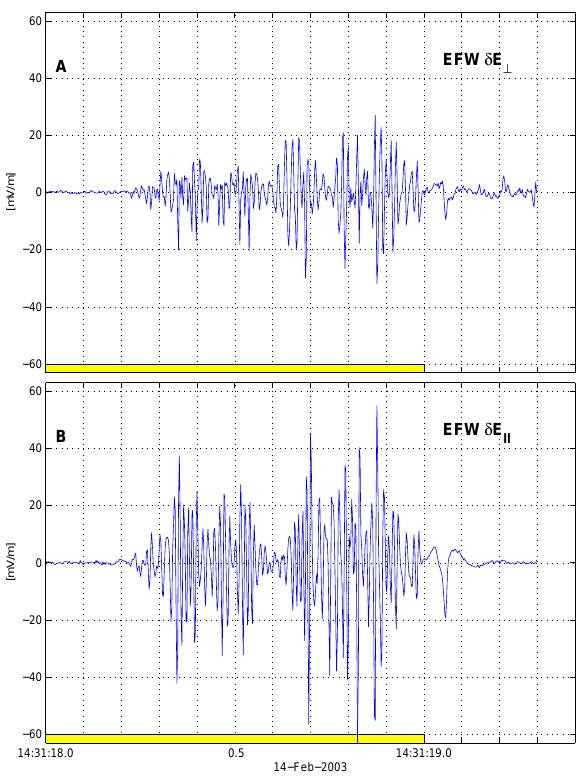
Fig. 10. For 1.3s of data, including the one-second period high- lighted in yellow (also in Fig. 5) showing perpendicular (panel A ) and parallel (B) components of the electric field. By visual in- spection, the waveform during the first second (yellow) indicates that linear theory may be applicable but the structure at around 14:31:19.05 might be of a more nonlinear origin. See text for de-